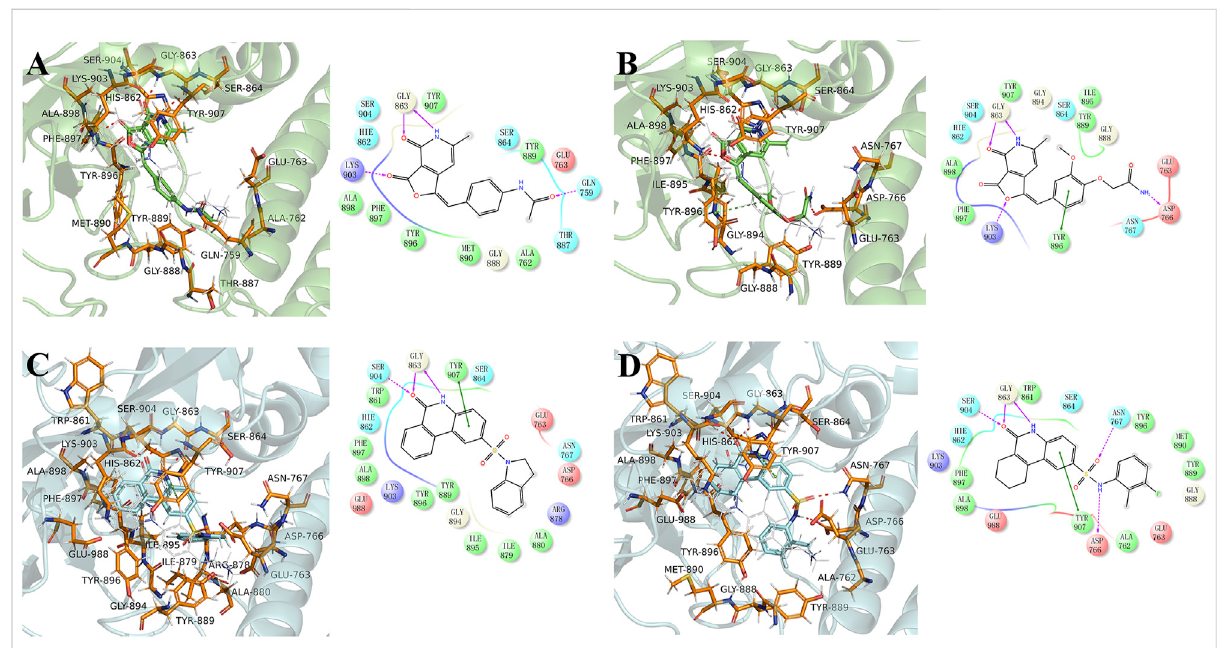
FIGURE 5 The binding mode analysis of four hit compounds, 8012-0567 (A) , 8018-7603 (B) , 8018-6529 (C) , 8018-7168 (D) in the equilibrium complex states. The equilibrium conformation for each hit compound was represented by the last snapshot during the 100 ns simulation trajectory. The PARP-1wasshowningreenorcyancartoon,whilethepocketresidues within4 Åoftheligandatomswereshowninorangesticks.Theligandswere shownincyan/greensticks,andNiraparibwasshowningraylinesfor locationcomparison. Thehydrogenbindingand π - π stackinginteractions were shown red and green lines in 2D and 3D interaction plots